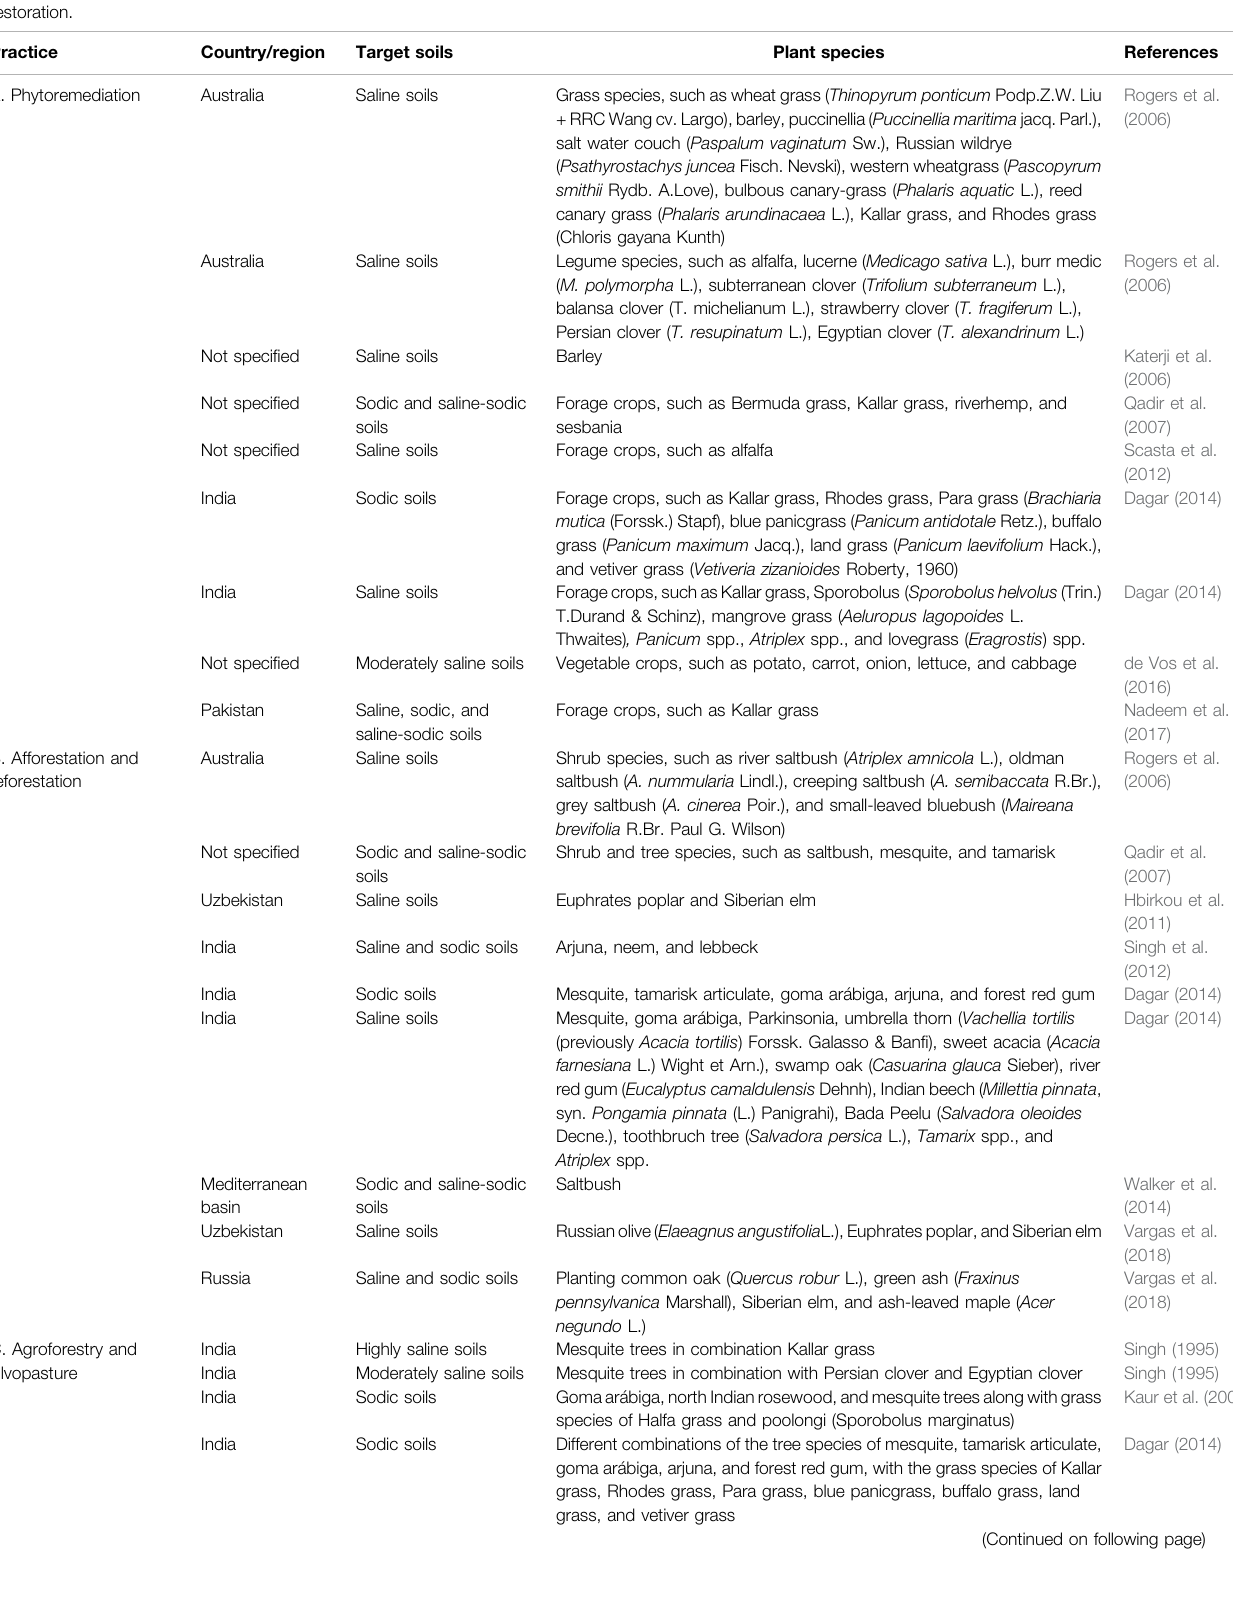
TABLE 5 | Major practices of phytoremediation (A) , afforestation and reforestation (B) , and agroforestry and silvopasture (C) , for soil salinity and sodicity prevention and restoration.